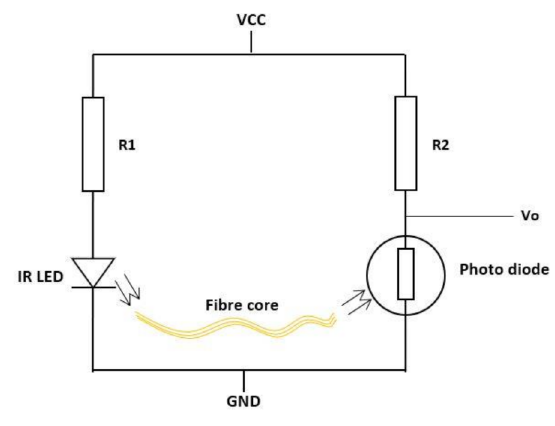
Figure 9. Fiber optic